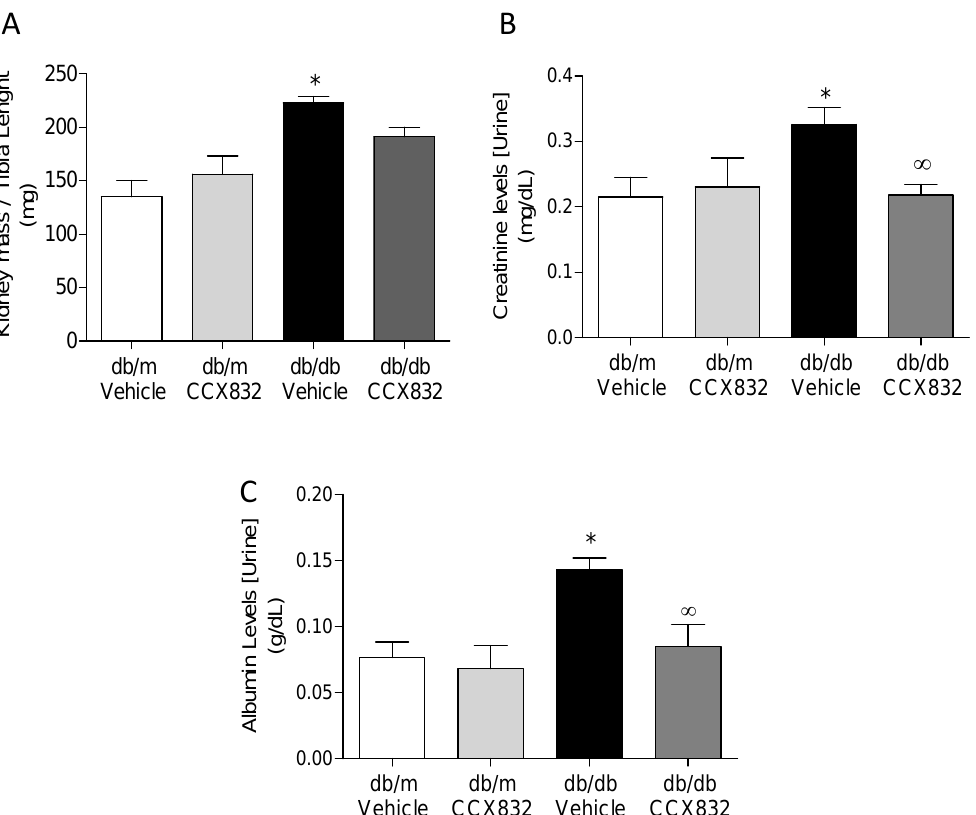
Figure 1. ChemR23 antagonism decreases albuminuria and urinary creatinine levels in db/db mice. Kidney mass ( A ) urinary creatinine, ( B ) and albumin levels, ( C ) in vehicle-treated or CCX832-treated db/m and db/db mice. Kidney mass (g) was normalized by the tibia length (mm). Values represent the mean ± SEM (standard error deviation) of 5 to 8 experiments. * p < 0.05 vs. db/m, ∞ p < 0.05 vs. db/db vehicle .